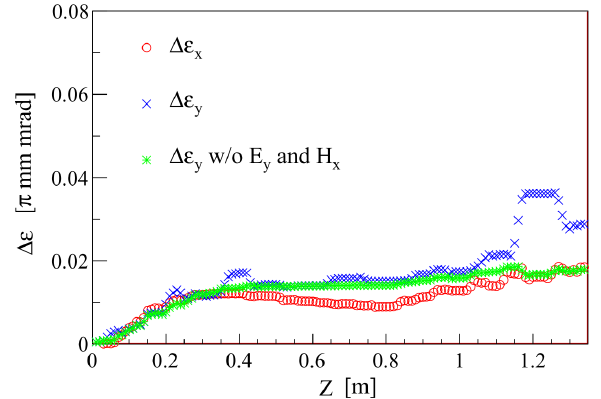
FIG. 7. Emittance growth ( Δ ε ) along beam axis (z). Red: emittance growth in the x-direction ( Δ ε growth in the y-direction ( Δ ε y-direction without the vertical electric field ( E horizontal magnetic field ( H